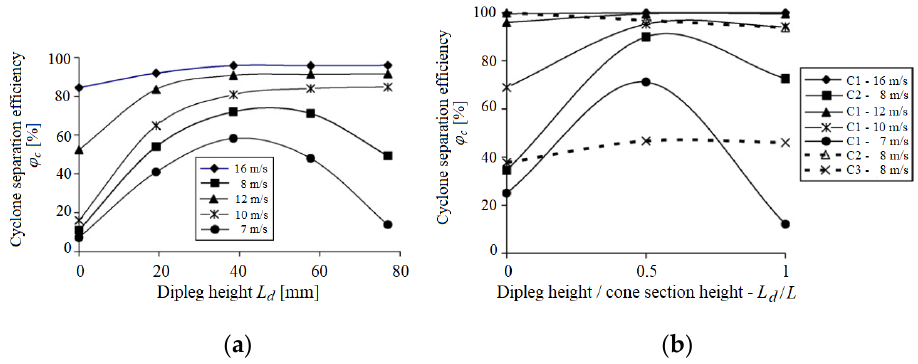
Figure 20. Cyclone separation efficiency for different inlet velocities depending on ( a ) dipleg length L d and ( b ) L d / L parameter value. Figure made by the author based on data from the work [89].